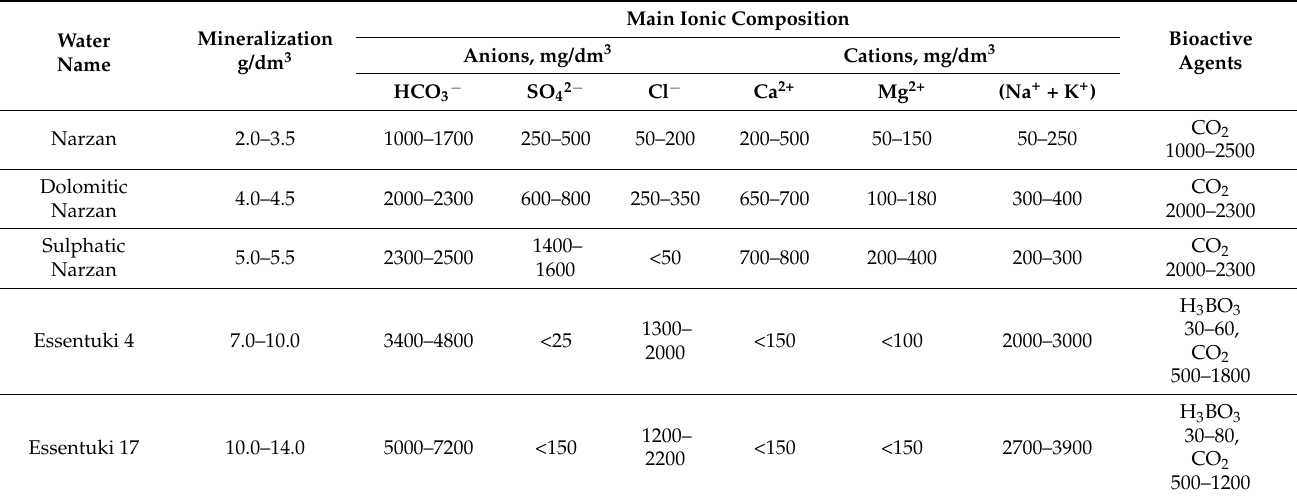
Table 1. The chemical compositions of CMW region’s mineral